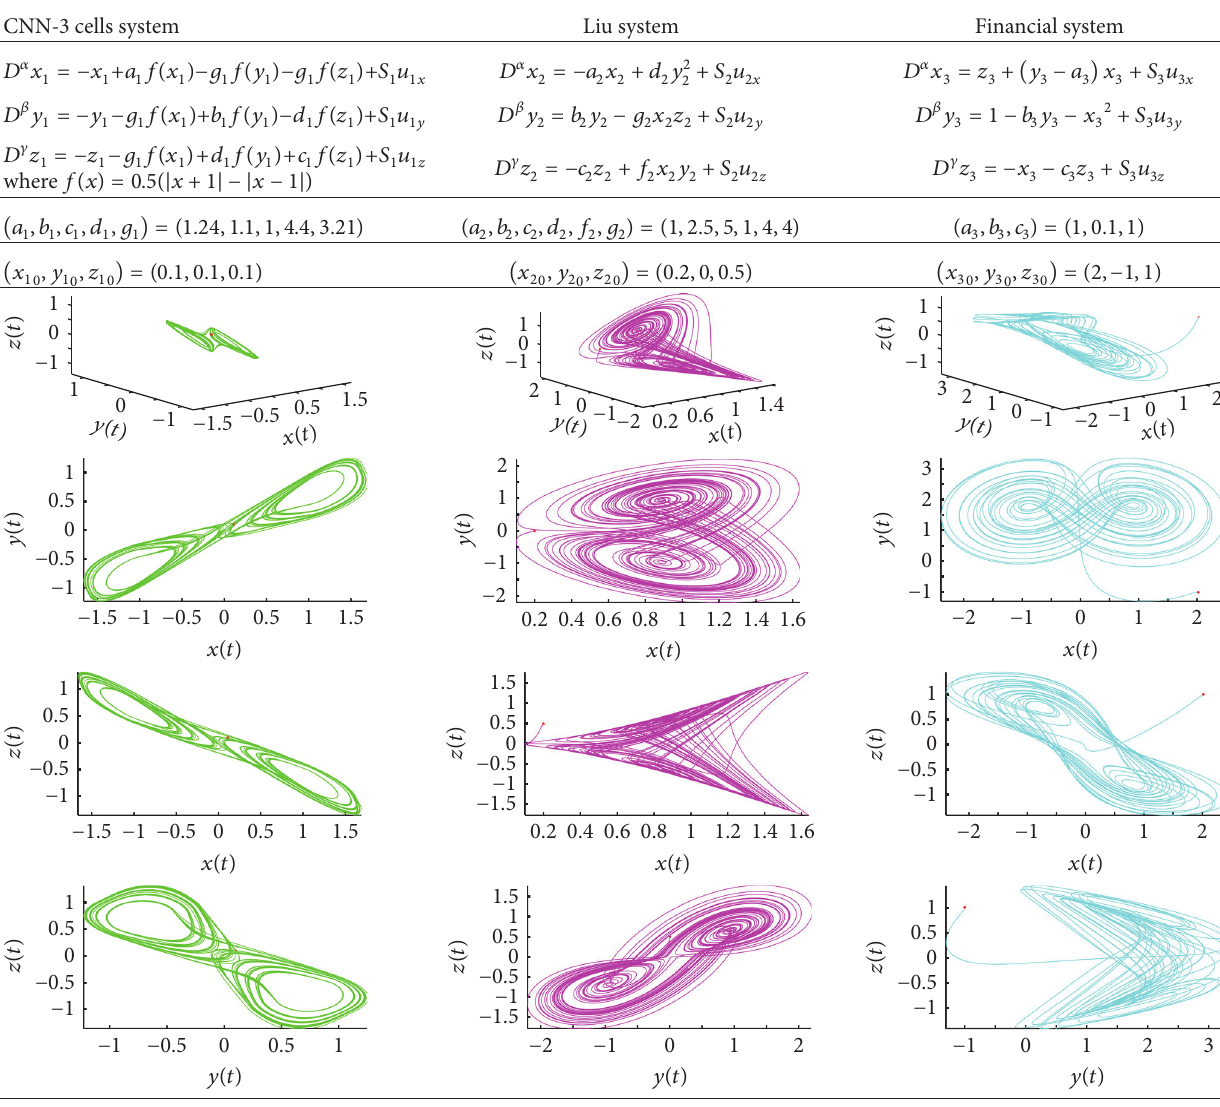
Table 1: Equations, parameter values, initial conditions, and strange attractors of the utilized systems at (𝛼,𝛽,𝛾) = (0.99,0.99, 0.99) . CNN-3 cells system Liu system Financial